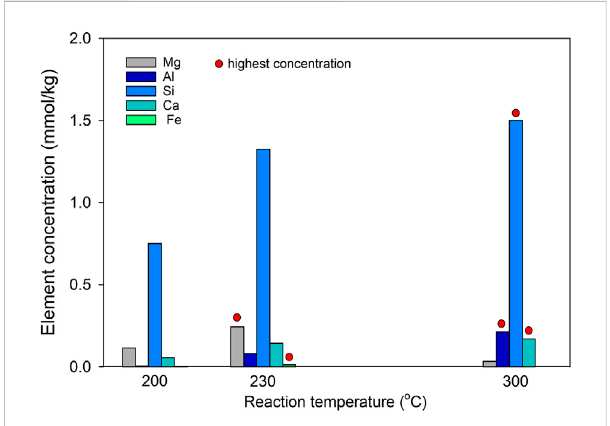
FIGURE 6 Concentrations of Mg, Al, Si, Ca, and Fe in NaHCO 3 solutions after reacting with basalt at 200 ° C, 230 ° C, and 300 ° C for 5 days (Runs 2 – 4).